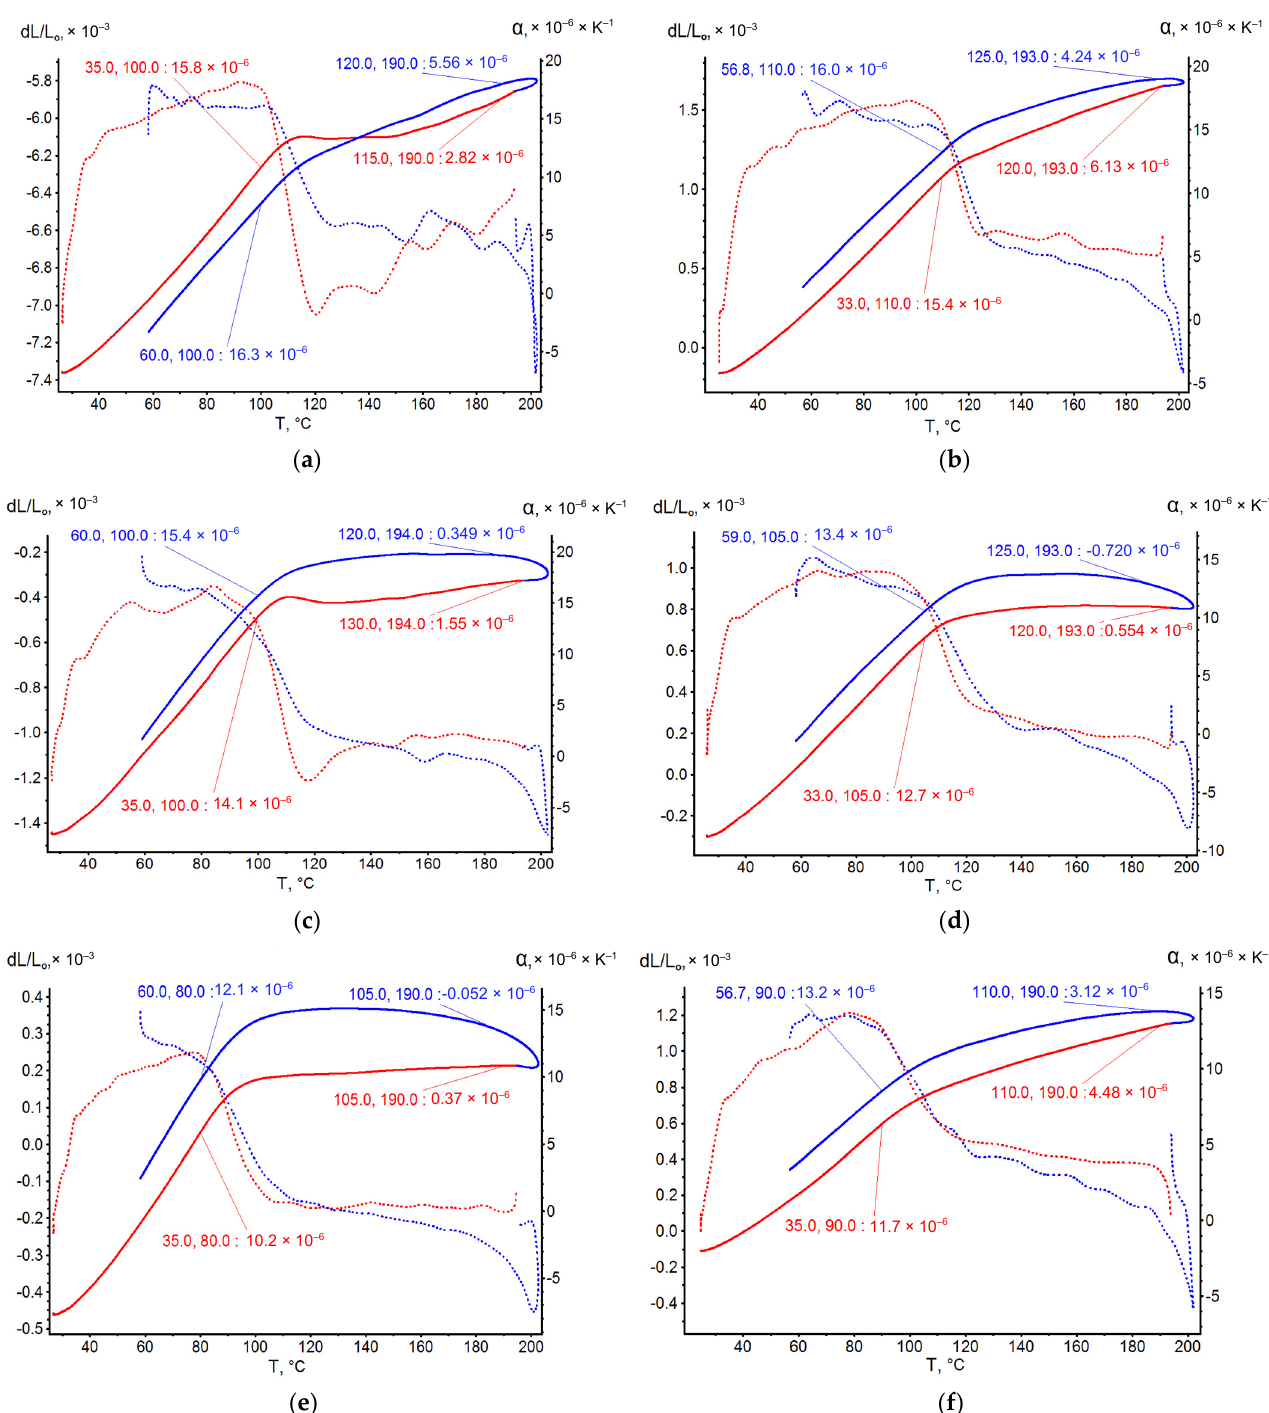
Figure 11. Dilatometric curves of GRPs under heating. ( a ) EP+EZ, ( b ) EP+EZ T-relax, ( c ) EP+T23, ( d ) EP+T23 T-relax, ( e ) EP-PF+EZ, ( f ) EP-PF+EZ T-relax.